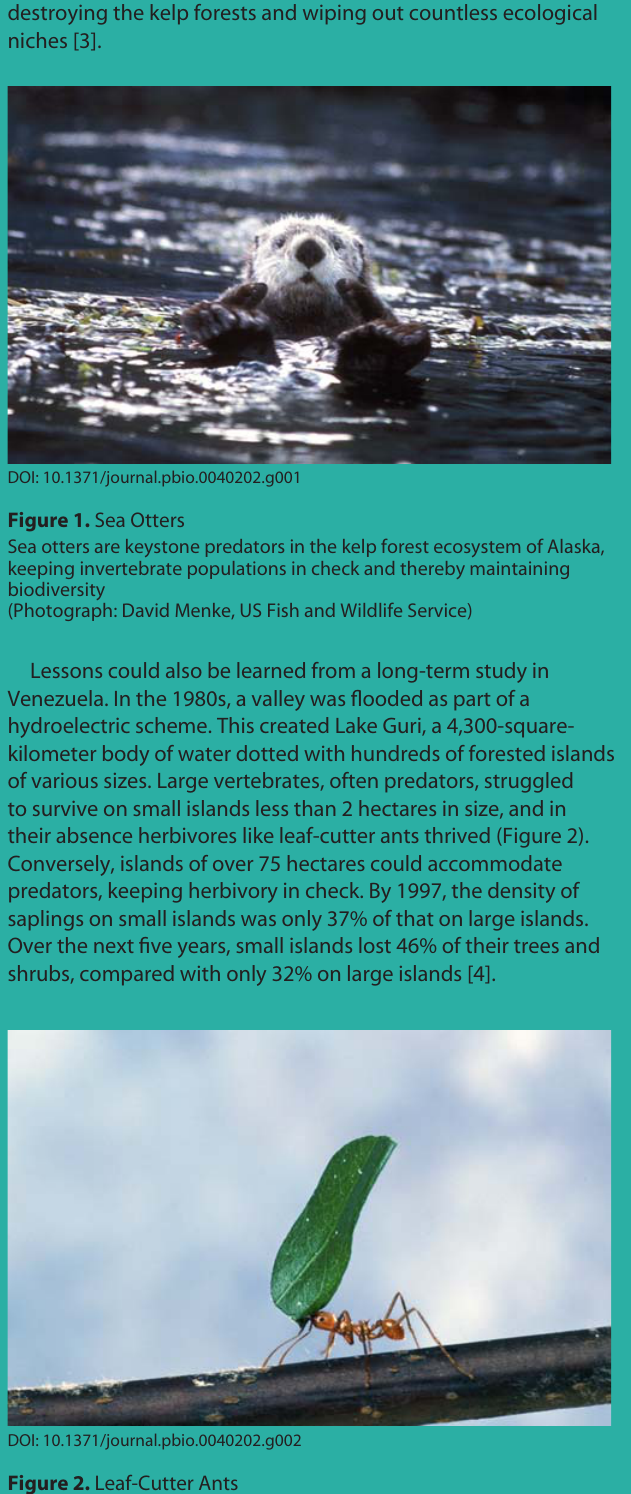
Figure 2. Leaf-Cutter